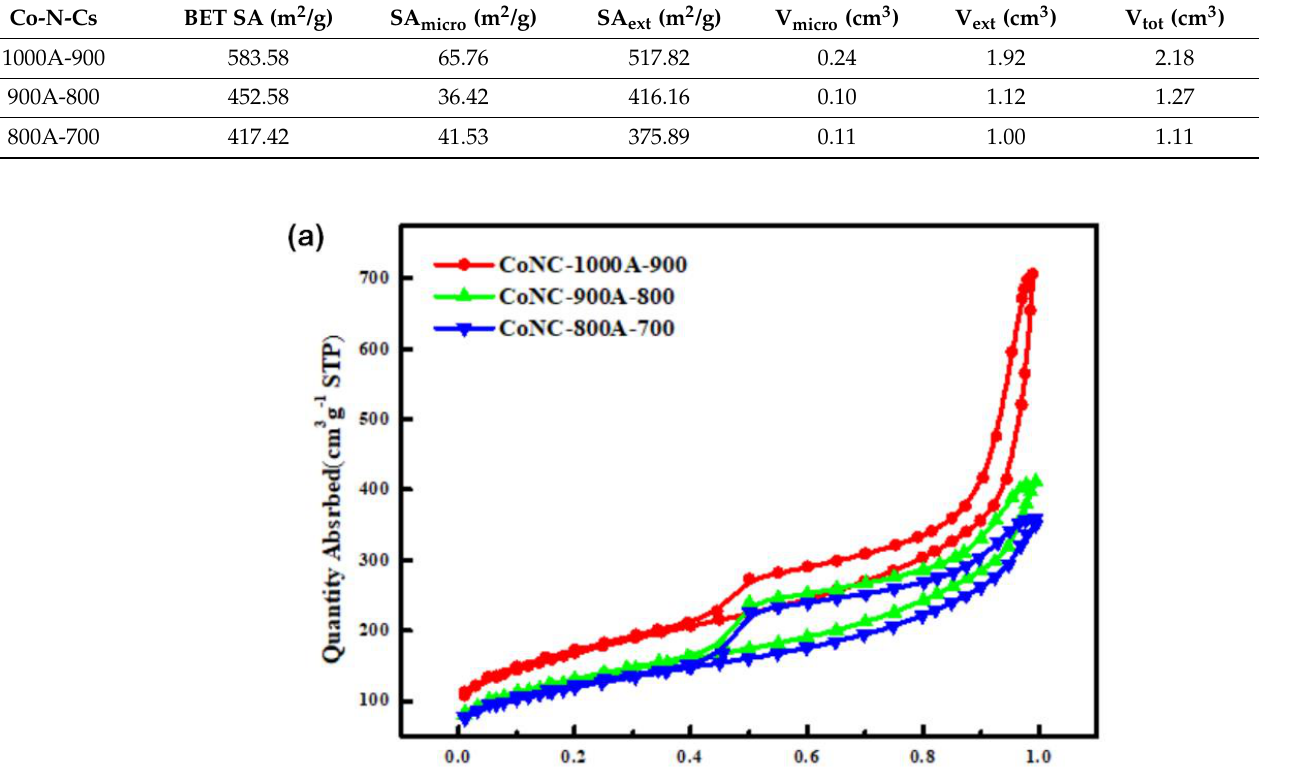
Table 3. Various surface areas (SA) and volumes (V) of Co-N-C catalysts.